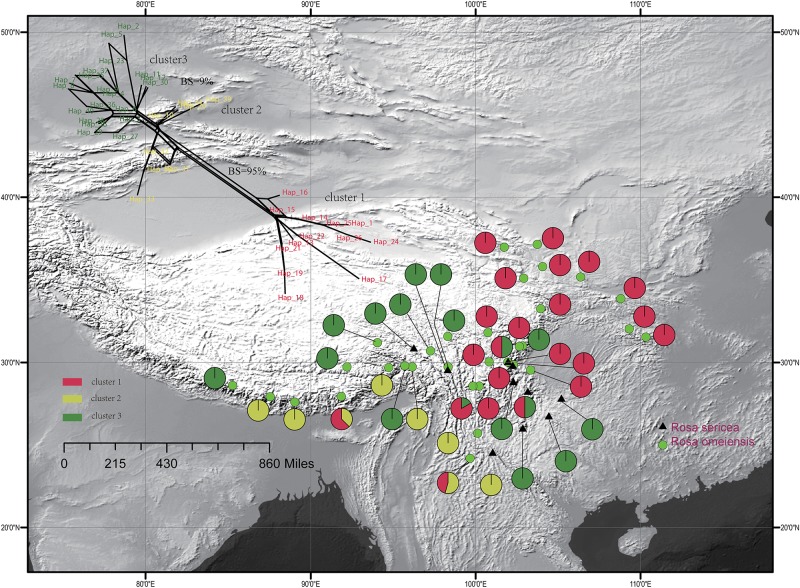
Geographic distribution of the 42 populations of the R. sericea complex color-coded according to the network analysis of the phased genetic sequences from LEAFY. Network shown at top and constructed in SplitsTree. Map generated in ESRI ArcGIS 10.0 (Esri, 2010).